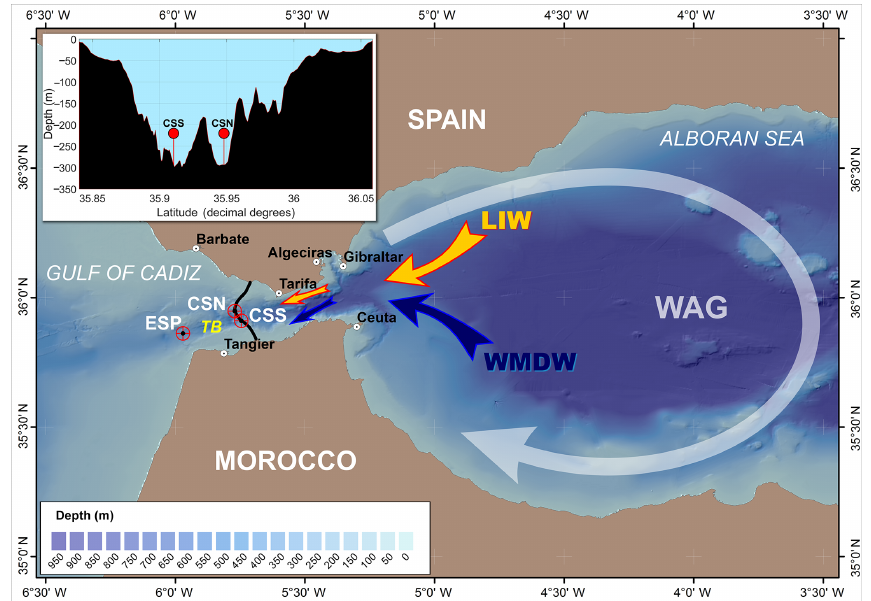
Figure 1. Map of the Strait of Gibraltar and westernmost area of the Alborán Sea. The inset on the upper left corner shows the bathymetry of the Camarinal Sill section (solid black line in the map) and the location of the two mooring lines deployed in the north and south channels of the section (sites CSN and CSS, respectively). The locations of the Espartel Sill long-term monitoring station of the outflow (ESP) and the Tangier Basin (TB) between both sills are also indicated. Coloured arrows sketch the main path of Levantine Intermediate and Western Mediterranean Deep waters (LIW and WMDW, respectively) in the Alborán Sea and in the eastern half of the strait. The Western Alboran Gyre is represented by the white